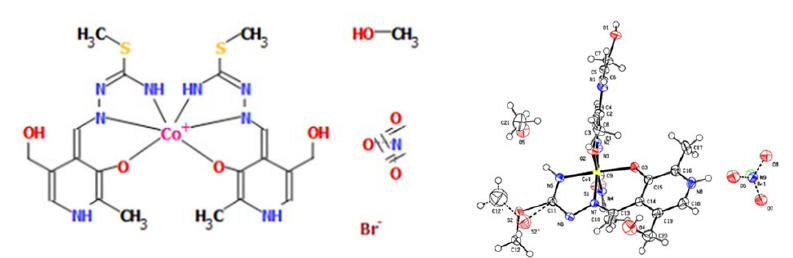
Figure 1. Octahedral geometry of Cobalt complex (left) and molecular structure of the complex compound 1 with the atom and ring-labeling scheme (right). Table 2. The bonds length and Angles [°] of Co complex.